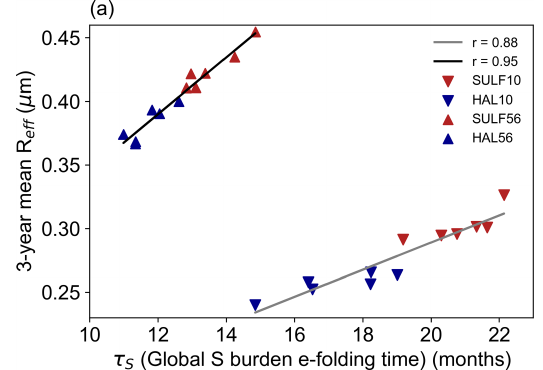
Figure 3. Global-mean aerosol effective radius over the first 3 post- eruption years as a function of the global total sulfur e -folding time. Both plots have regression lines fitted with correlation coeffi- cient ( r ) showing strong positive